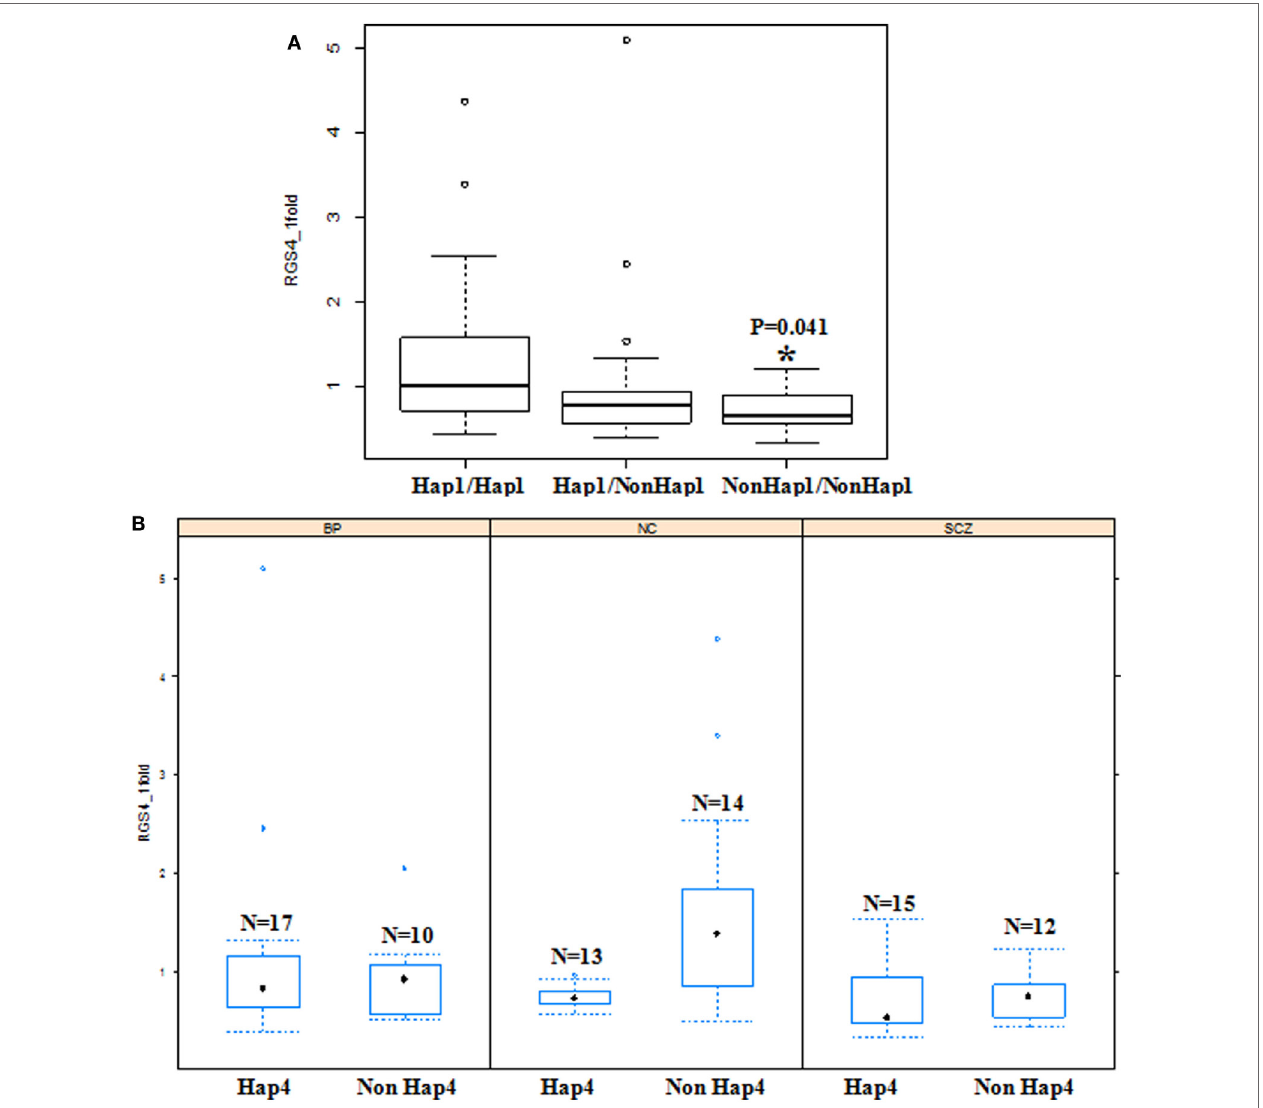
FigUre 7 | effects of haplotypes on RGS4-1 mrna expression . (a) Effect of haplotype 1(Hap1) on the mRNA expression of RGS4-1. The individuals with diplotype of two non-Hap1 have lower RGS4-1 mRNA expression level ( p = 0.0413). (B) In the SCZ group, non-Hap4 carriers have lower RGS4-1 mRNA expression level compared to those with non-Hap4 in NC ( p = 0.0192). Hap1 is CACCG, Hap4 is